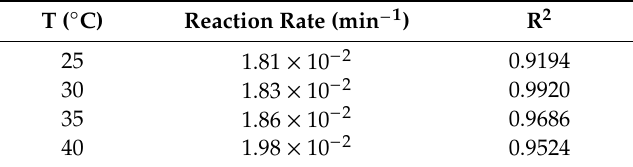
Table 5. The reaction rate of tetracycline degradation at di ff erent temperatures.